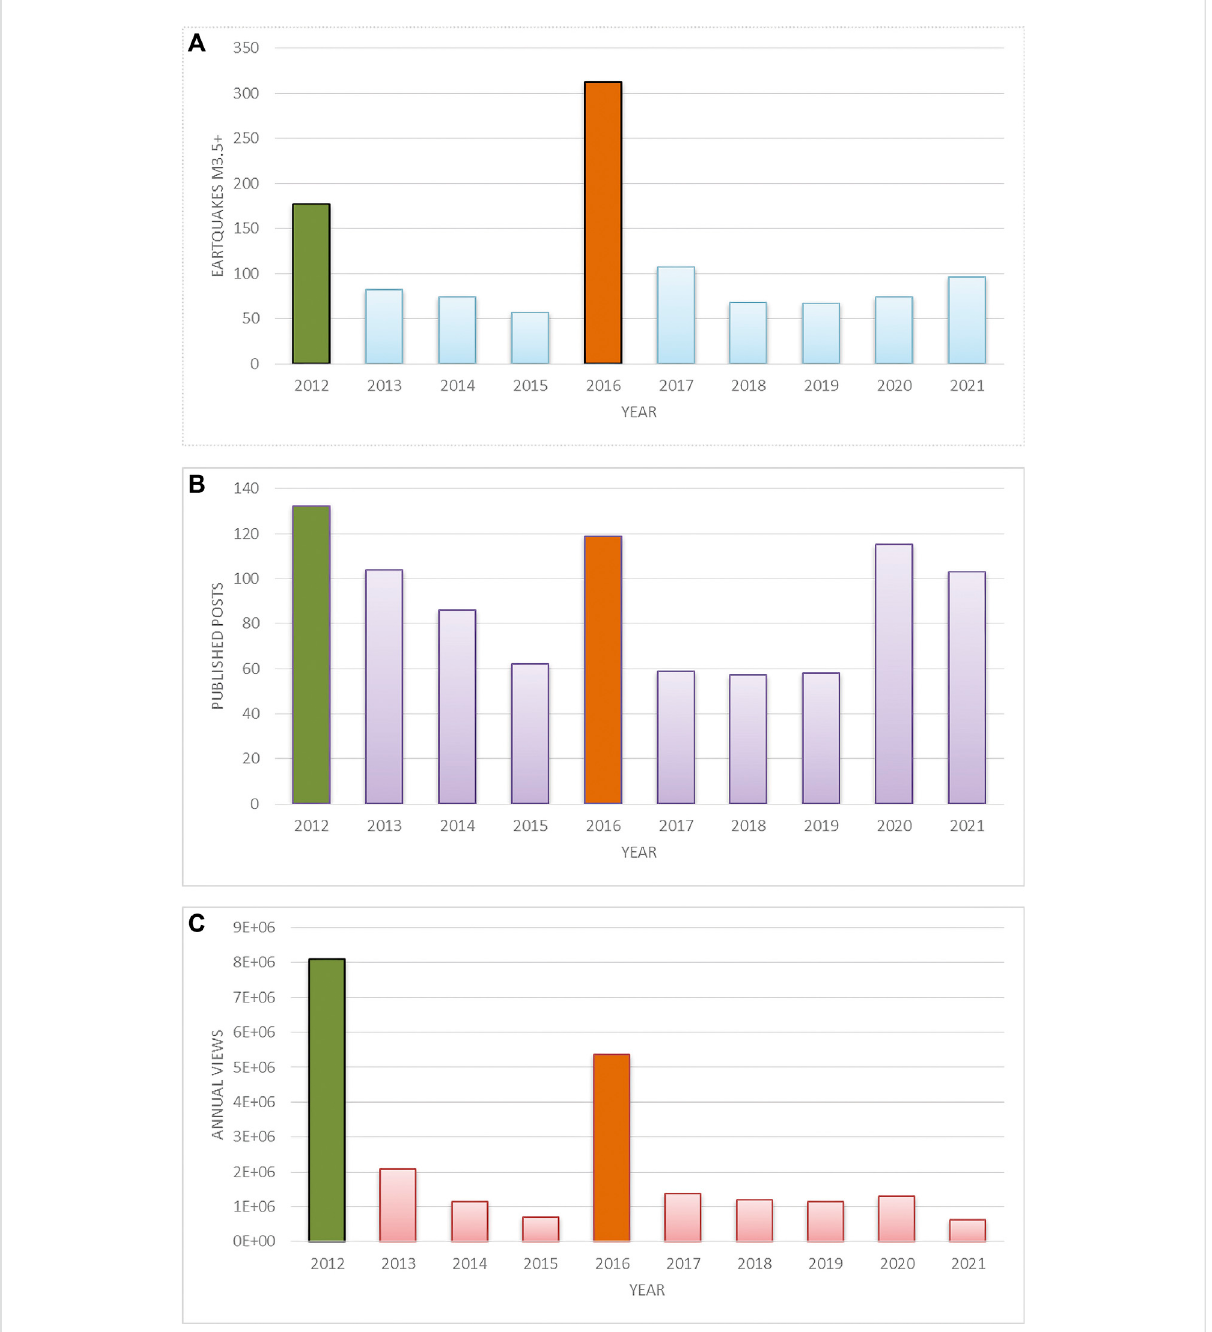
Comparison between: (A) annual number of earthquakes with magnitude M3.5+ in the area that also includes Italy (lat. 35 – 49; long. 5 – 20); these are events that also occur outside the national territory; (B) annual number of articles published on the blog; (C) annual number of blog views. We note that the blog had the peak of monthly views (5 million) in June 2012 for the Emilia, 3 June 2012 earthquake (magnitude M L 5.1). This is probably due to the fact that INGV websites in 2012 had many dif fi culties in being reached by a huge number of users such as those involved in the Po Valley area. The reachability problem of INGV websites was solved in the following years, and the sharing of earthquake data on different INGVterremoti social media was implemented considerably, so the blog in 2016 had a lower views number than in 2012, even if still